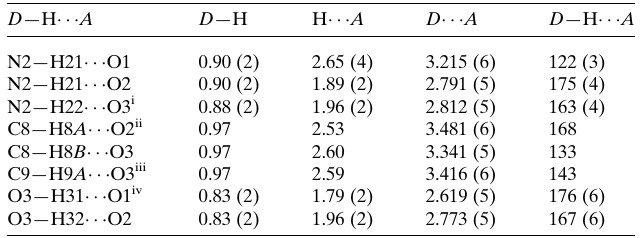
Table 1 Hydrogen-bond geometry (A˚ , (cid:5) ) for 1 .